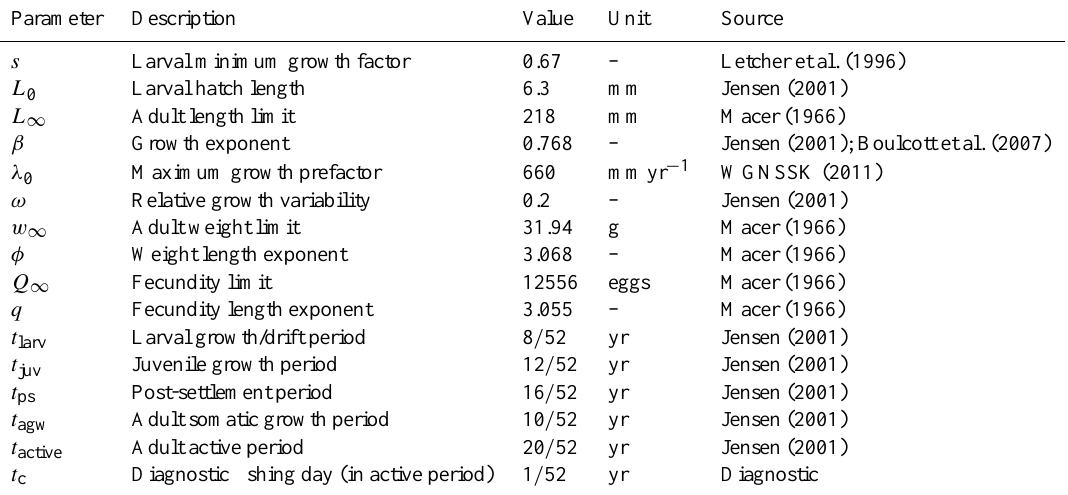
Table 2. Biological parameters in the SPAM model.